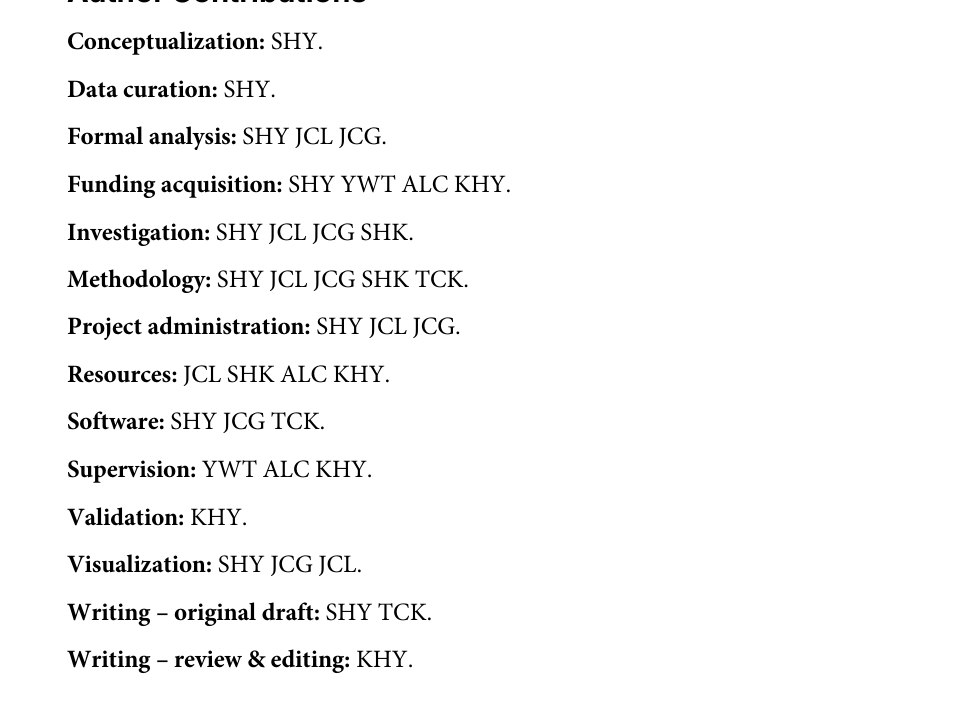
S1 Table. Summary of first-line and second-line gemcitabine-based chemotherapy. S2 Table. Association of MDM2 and p53 with clinical characteristics. S3 Table. Association of MDM2/p53 expression and surgery status. S4 Table. Association of MDM2/p53 expression, surgery status, and OS after gemcitabine- based chemotherapy. S5 Table. Association of MDM2/p53 and PFS/OS in stage III/IV patients with first-line gemcitabine (N = 36). S6 Table. Clinical characteristics and missing data. S7 Table. Multivariate analysis for OS in subjects without missing